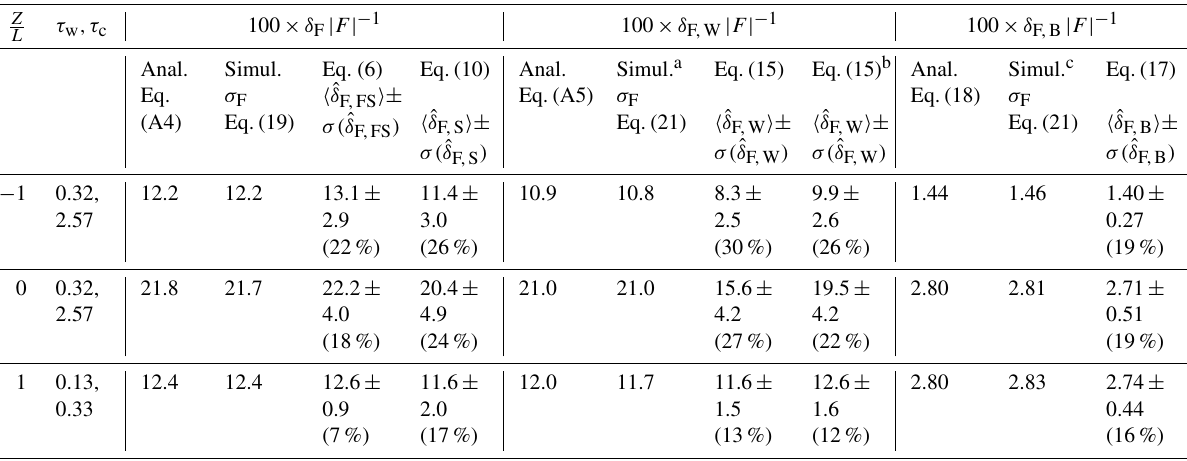
Table 1. Flux error estimates δ F , δ F,W and δ F,B obtained from theory and simulations. Height to wind speed ratios ZU − 1 = 10s ( Z denotes the height above the displacement height i.e. Z = z − d) . Number of simulated realisations N = 10000. τ w and τ c denote the timescales of simulated series w and c in Eq. (A1). The values in the parenthesis indicate the uncertainty of the error estimates (obtained from Eq. 22) (cid:16) ˆ (cid:17) (cid:104)ˆ δ F δ F (cid:105) − 1 . relative to the average values in percent i.e. 100% × σ